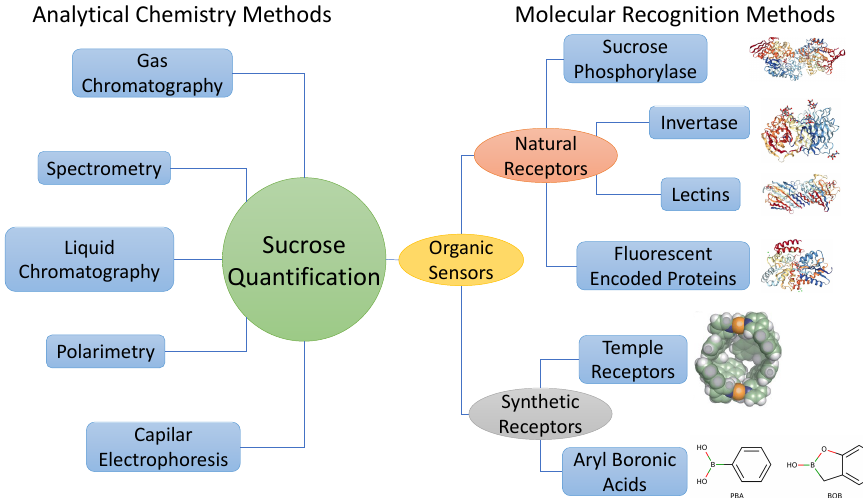
Figure 1. Overall sucrose detection and quantification techniques discussed in this review.